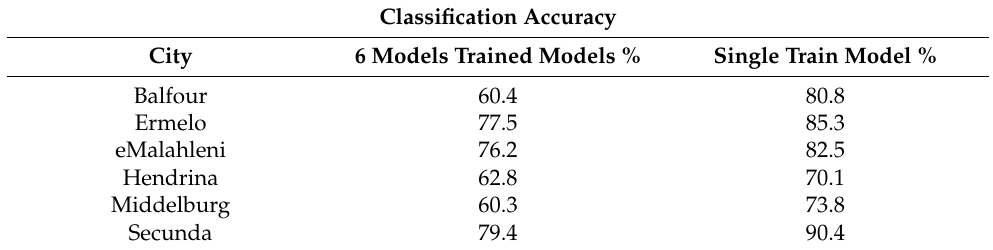
Table 3. Classification accuracy for the trained six cities model and the trained single model.